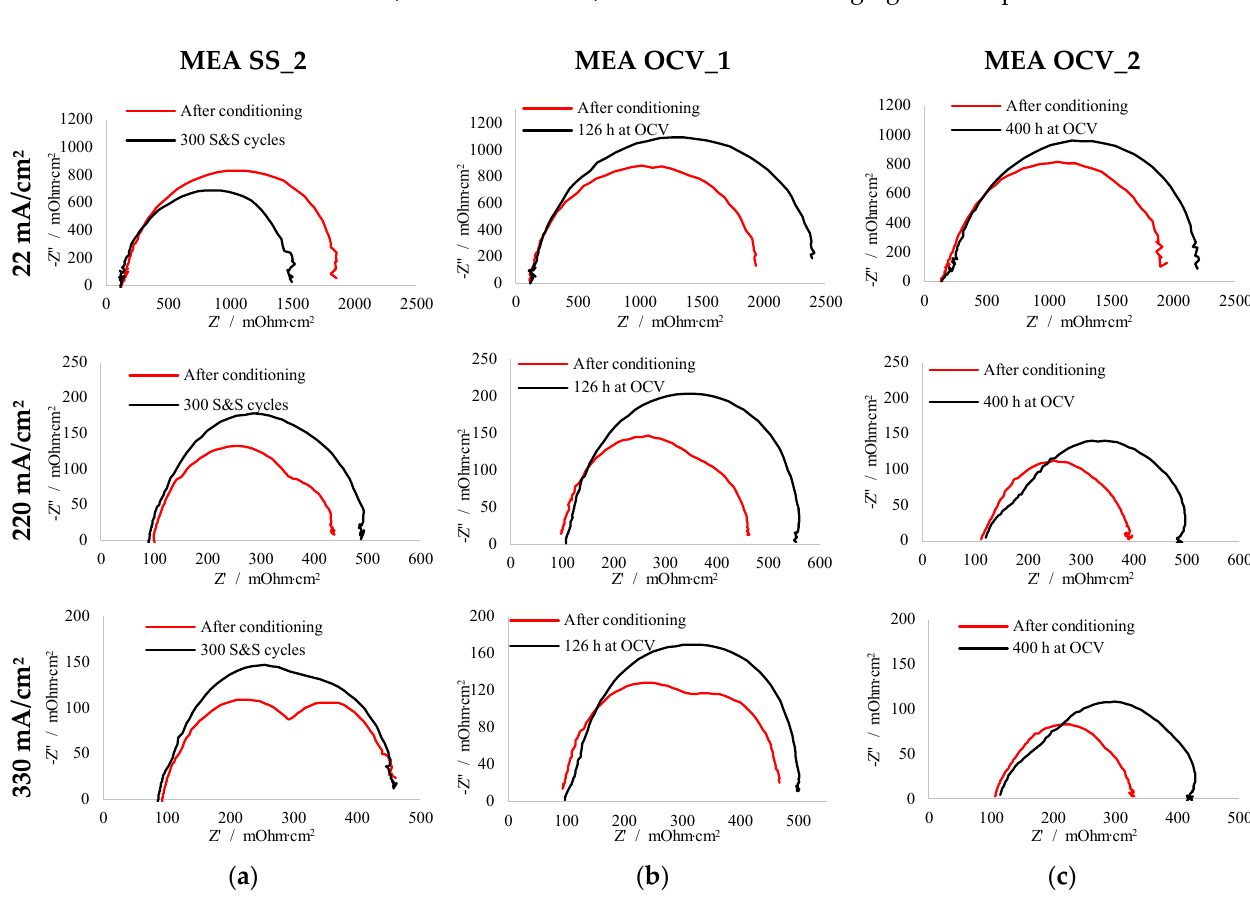
Figure 4. EIS spectrum at 22 mA/cm 2 , 220 mA/cm 2 and 330 A/cm 2 of ( a ) MEA SS_2, ( b ) MEA OCV_1, ( c ) MEA